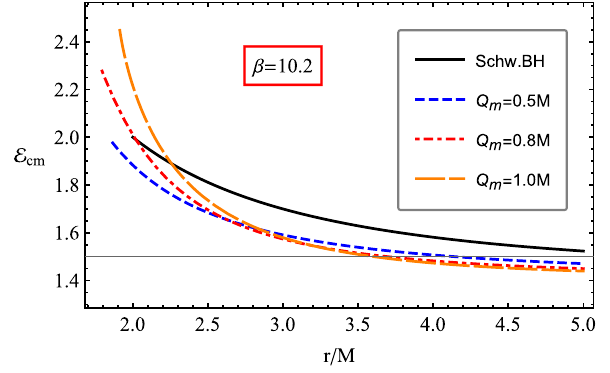
Fig. 12 Dependence of center-of-mass energy of collision of neutral and magnetized particles with the same initial energies E 1 = E 2 = 1, around the magnetically charged RN black hole for the different values of the magnetic charge parameter for the fixed value of the parameter β = 10 . 2 for the magnetized